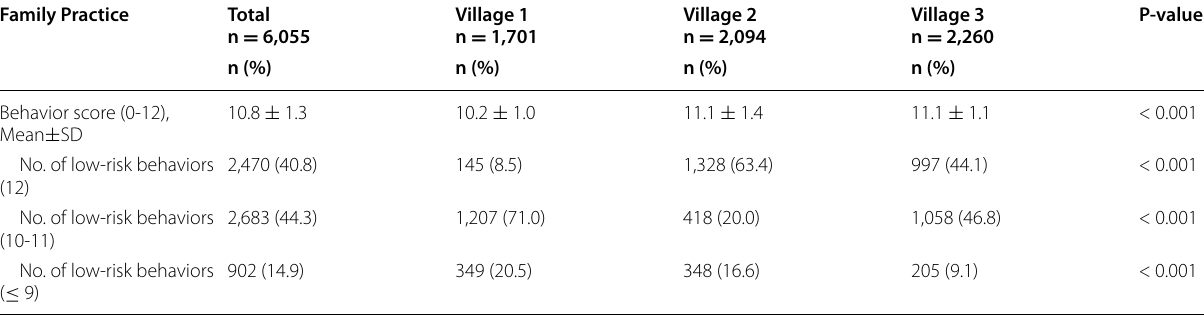
6,055 households) =